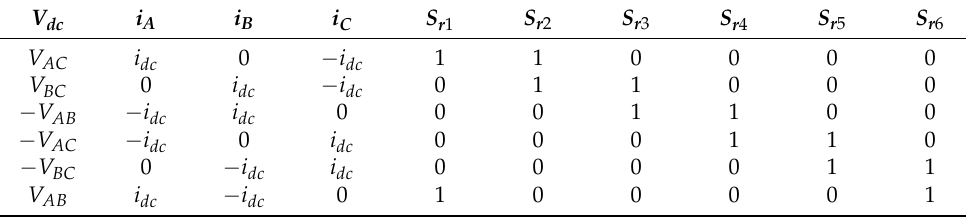
Table 1. Valid switching states of the rectifier.